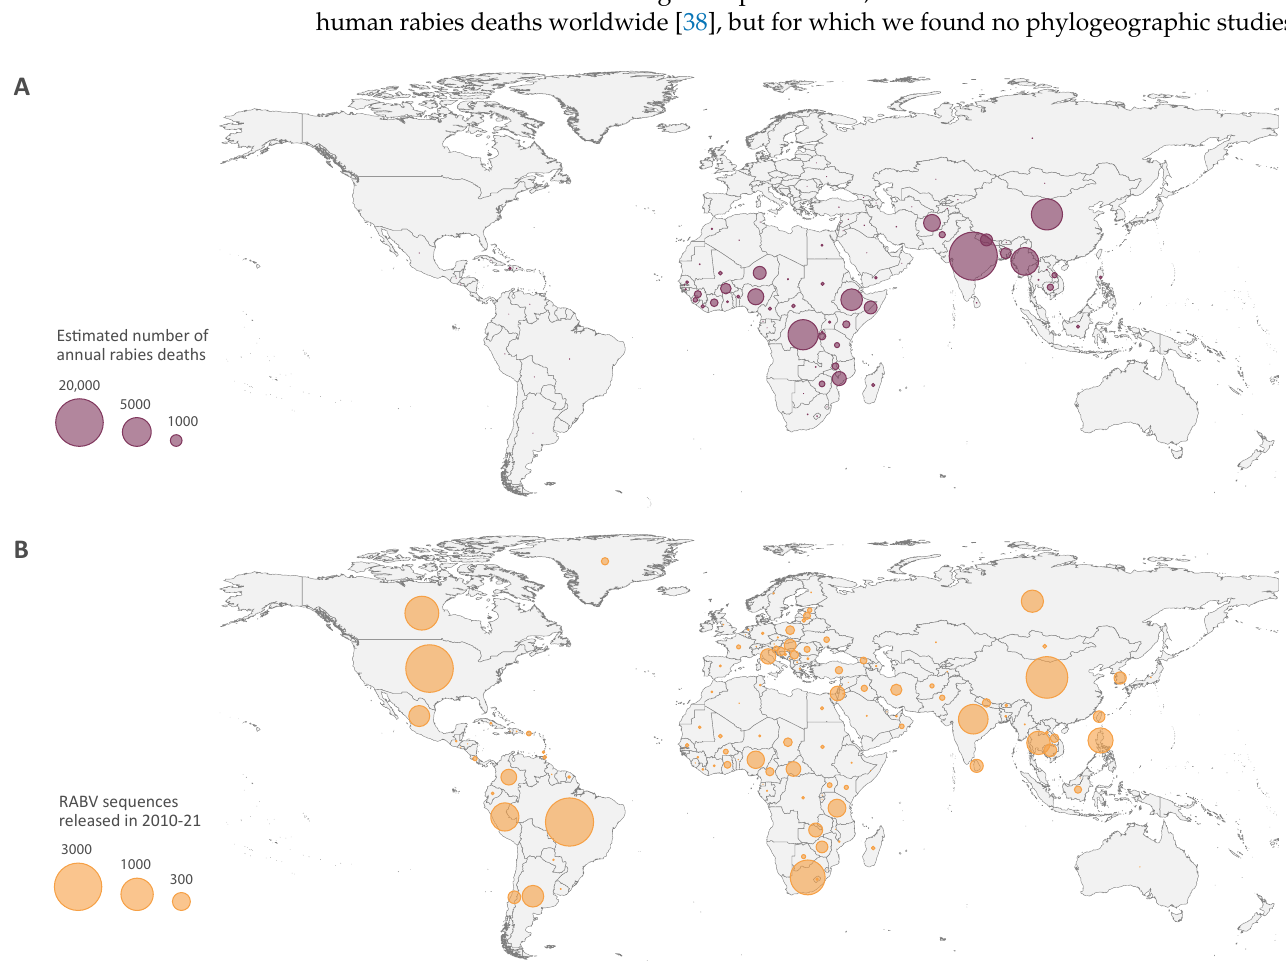
Figure 1. World maps showing the global incidence of the yearly number of deaths due to canine-associated rabies as estimated by Hampson et al. [38] ( A ), and the number of (partial and whole genome) sequences for rabies lyssavirus on GenBank collected between 1 January 1882 and 15 March 2021 (in any host; B